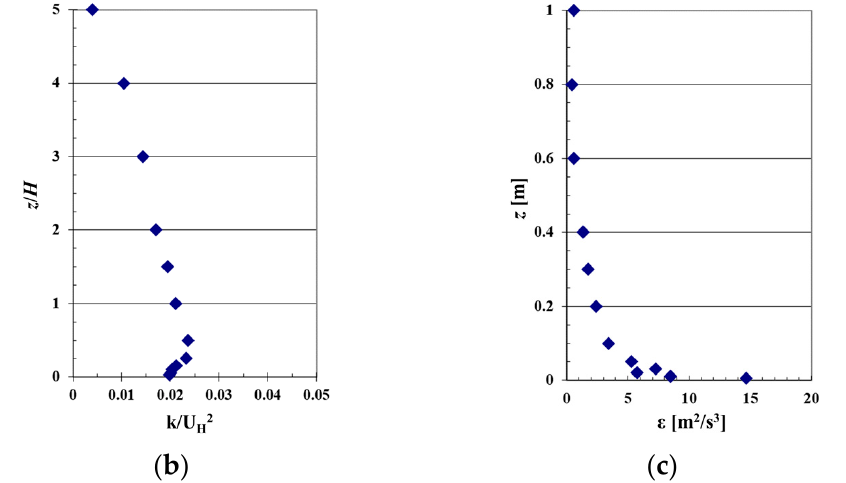
Figure 1. Incident profiles of the flow field ( a ) normalized streamwise velocity; ( b ) normalized turbulence kinetic energy; ( c ) turbulent dissipation rate.